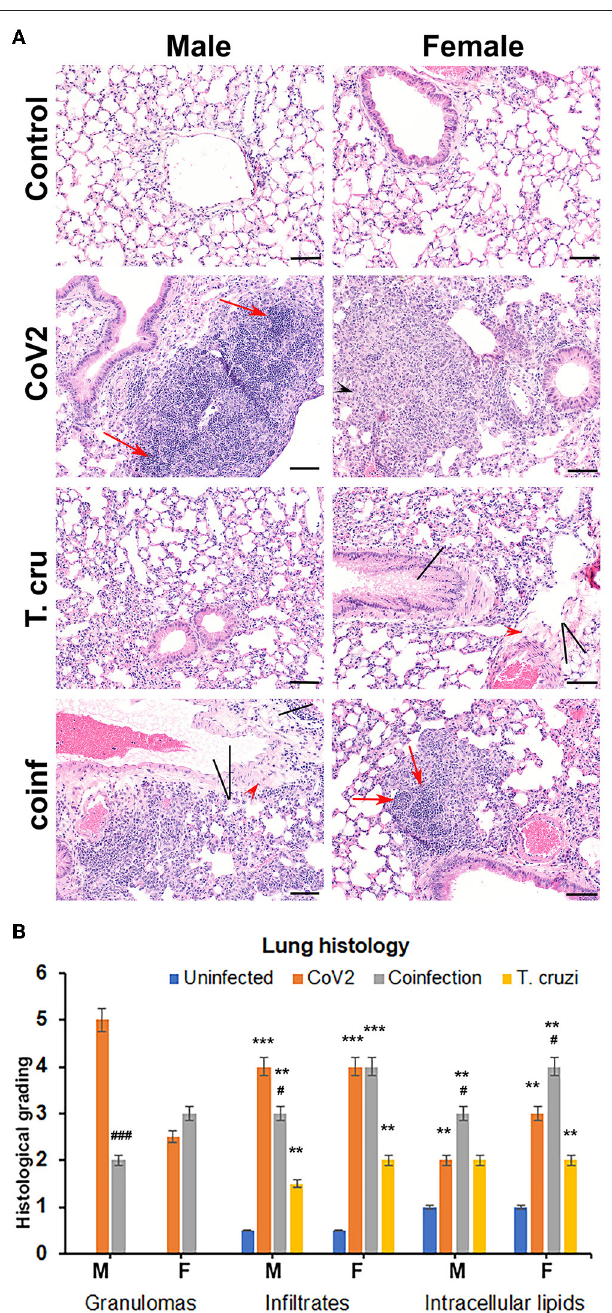
FIGURE 1 | T. cruzi infection modulates pulmonary pathology in CoV2 infected huACE2 mice. (A) H&E stained lung sections ( n = 4/sex, a minimum of five images/section were analyzed) of both male and female uninfected, CoV2 infected, T. cruzi infected, and coinfected huACE2 mice showing infiltrated immune cells (black arrowhead), accumulated lipid droplets (black line), fibrosis (red arrowhead), and granulomas (red arrow) (20x magnification, bar-200 µ m). (B) Histological grading of lung pathology was carried out according to experimental groups and classified in terms of granulomas (numbers), infiltrated immune cells, and accumulated lipid droplets. Each class was (Continued)